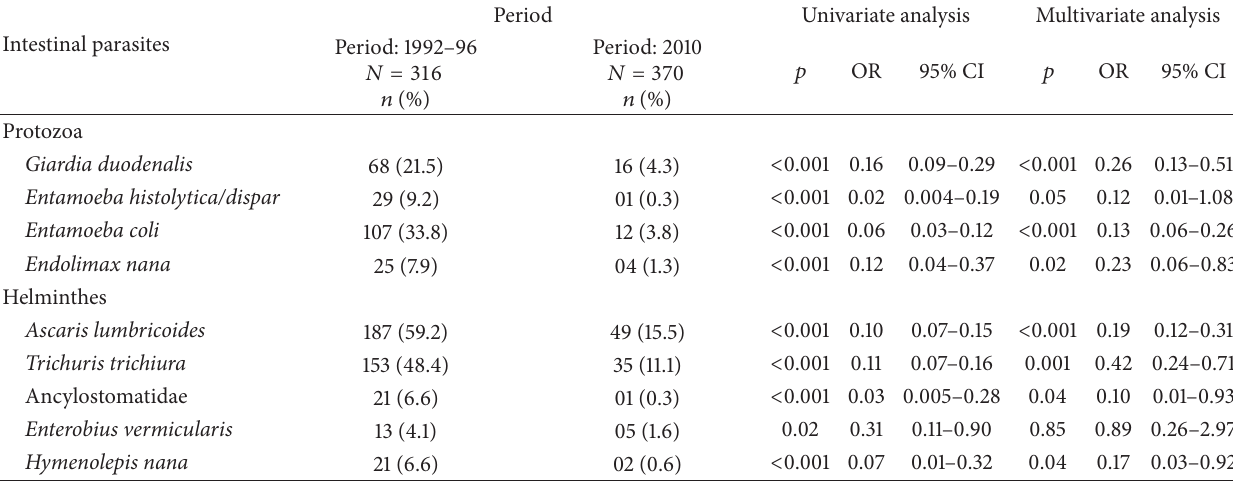
Table 1: Prevalence of intestinal parasites in stool collected in the period 1992–1996 and in 2010, Northeast Brazil. Period Univariate analysis Multivariate Intestinal parasites